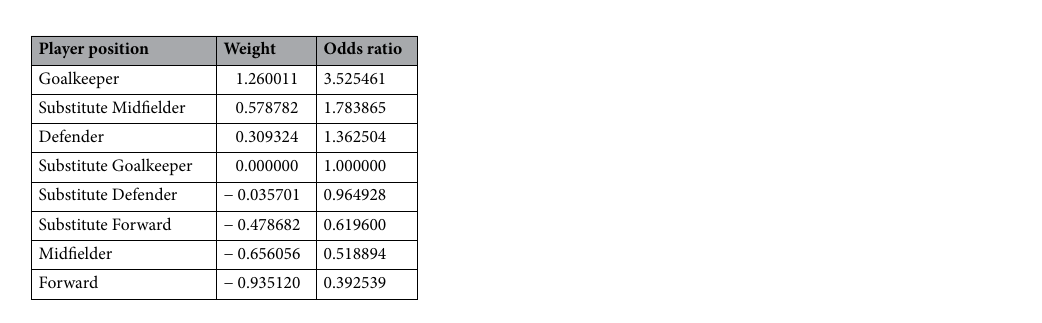
Table 5. Logistic regression model estimated weights and odds ratio for each possible value for Player